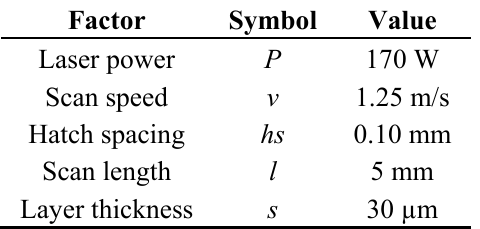
Table 11. Exposure parameters adopted for manufacturing the